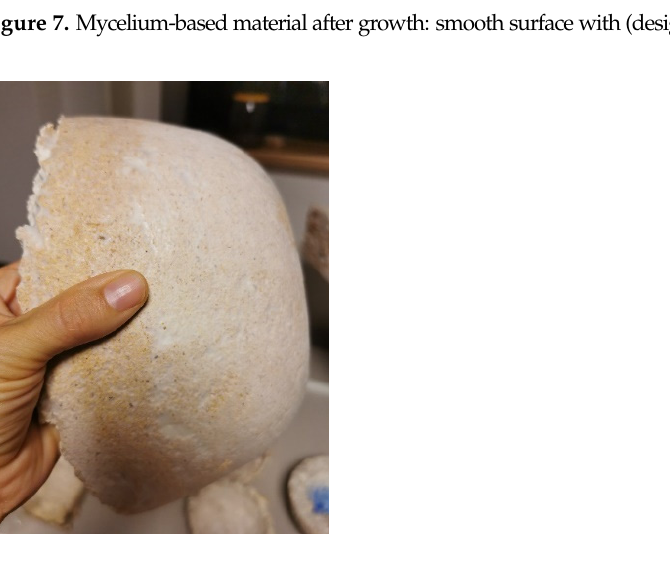
Figure 8. Mycelium-based composite: smooth texture, with visible fibres (design and photo: A. Bonenberg).